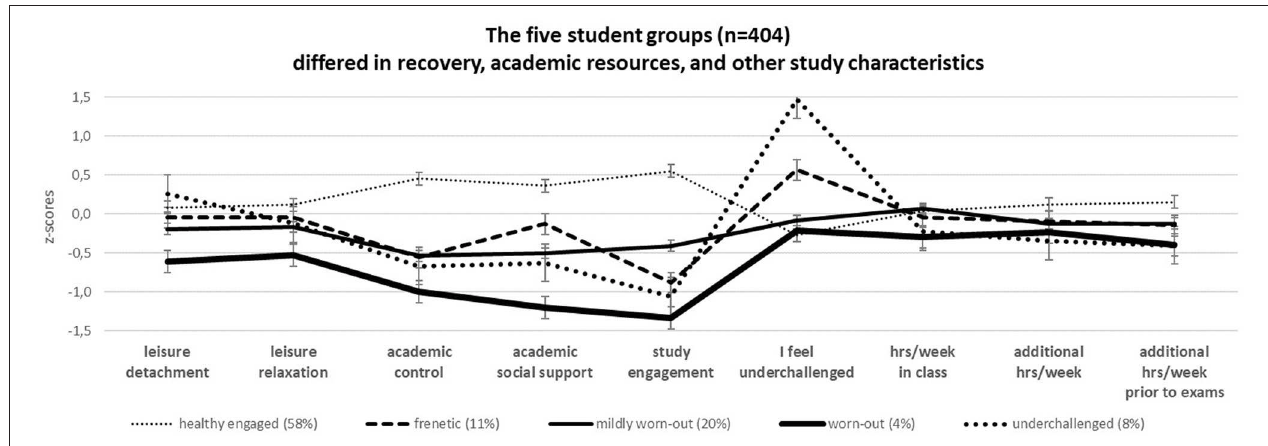
FIGURE 2 | Recovery, academic resources, and other study characteristics of the five BCSQ-12-SS classes in the entire sample.